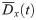
Estimates for cohort of individuals born after 1964, for years 1999–2013, from model (12), (13) calibrated using data listed in S4 Table and S5 Table.Blue circles denote observed annual numbers of HCC and hepatitis C diagnoses for this cohort. A: Model estimates of total number of HCC diagnoses. B: Model estimates of total number of hepatitis C diagnoses. C: Model estimates of CHC prevalence rate Rx(t). D: Model estimates of proportion of CHC population undiagnosed D¯x(t).